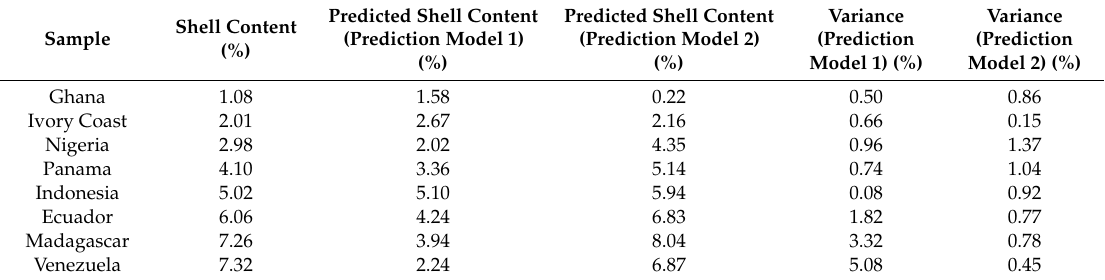
Table 4. Predicted and given cocoa shell content of 8 samples of di ff erent